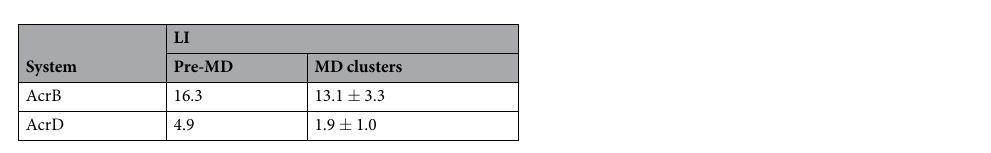
Figure 6. Volume dynamics of DP in the Tight protomer of AcrB and AcrD. (Left Panels) Volume distribution of DP in the Tight protomer of AcrB ( a ) and AcrD ( c ) over the simulation timescale. (Right Panels) Porcupine plots of the first principal-component eigenvector for DP in AcrB ( b ) and AcrD ( d ) simulations shown as arrows ( > 2 Å) attached to C α atoms indicating the magnitude of the corresponding eigenvalues.